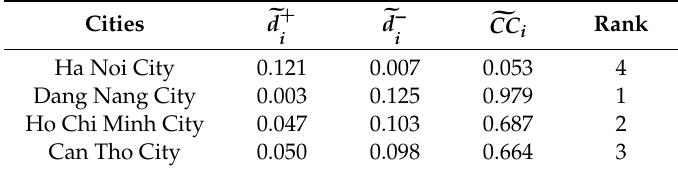
Table 17. Closeness coe ffi cients and rank of alternatives for environmental